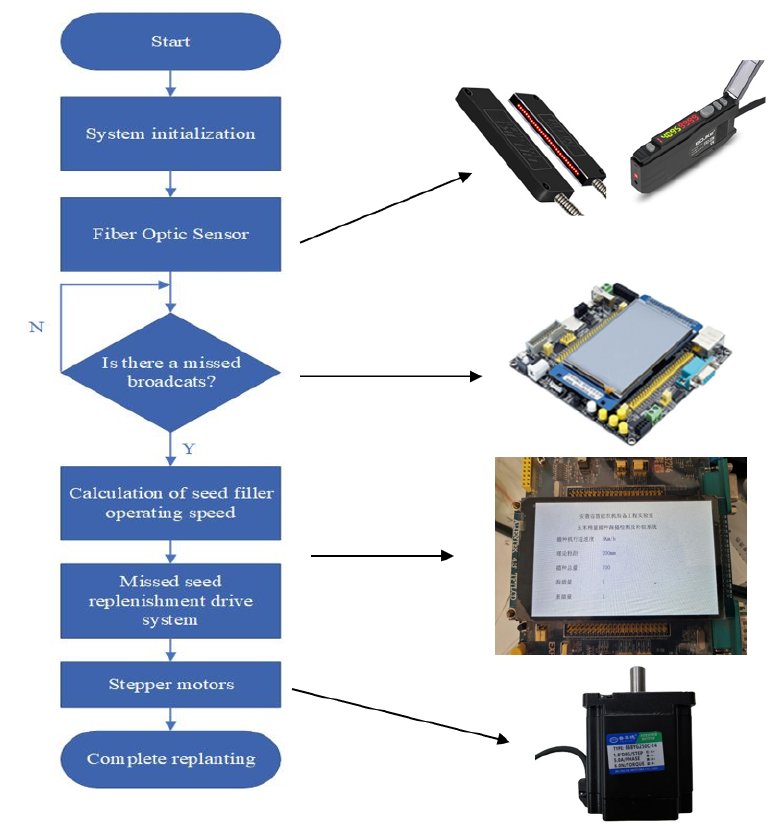
Figure 7. Work flow chart of reseeding system.